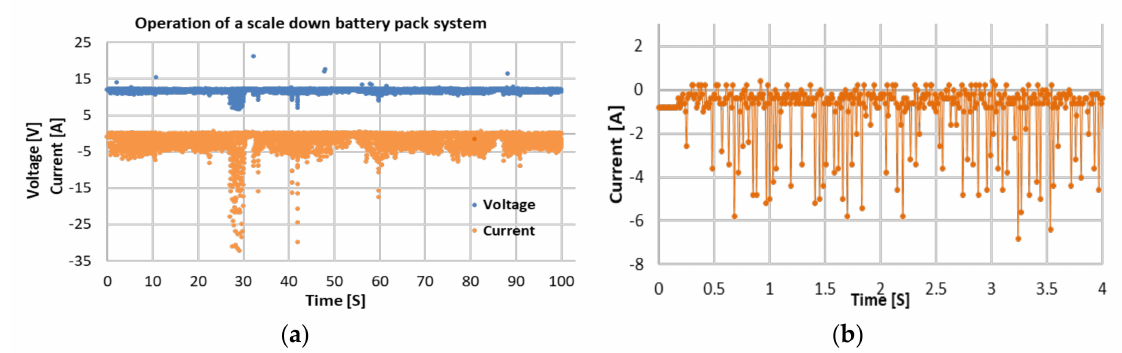
Figure 11. Dynamic arbitrary waveform: ( a ) during discharging of Li-Ion battery pack 3S6P configuration connected with BMS, ( b ) magnified current waveform.